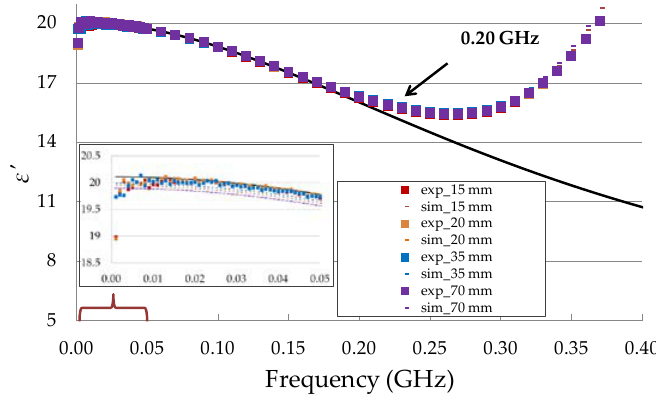
Figure 5. Comparison of ε ′ values for isopropanol obtained from simulation s (sim) and experiments (exp) for measurements in containers with different diameters (in mm). The black solid line corresponds to the Debye spectrum of isopropanol data obtained from available literature (T = 20 °C, ε s = 29, ε ∞ = 3.2, τ = 292 ps ) [25] .